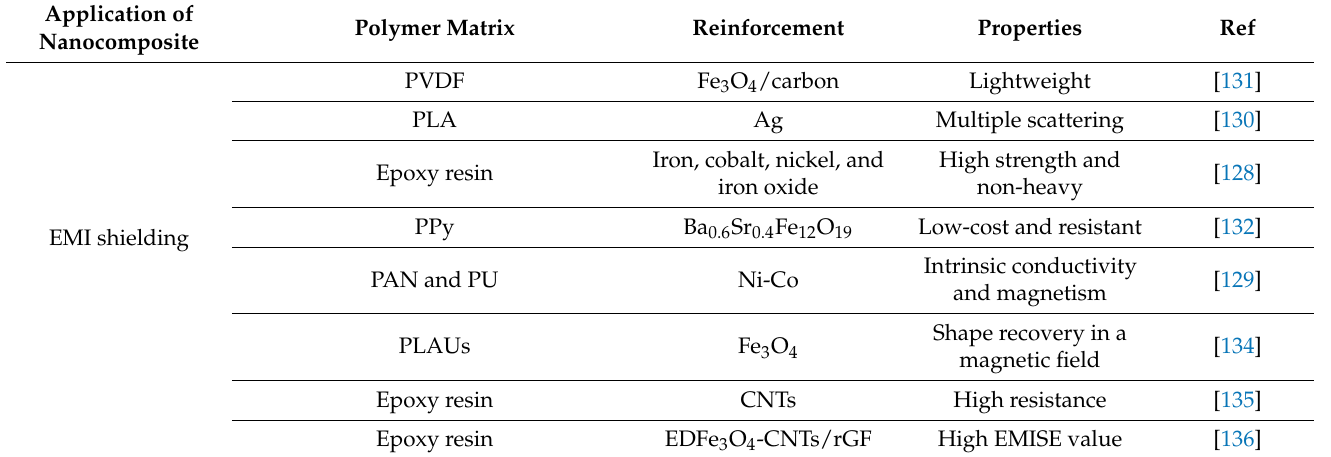
Table 6. Summary of aerospace application of polymer